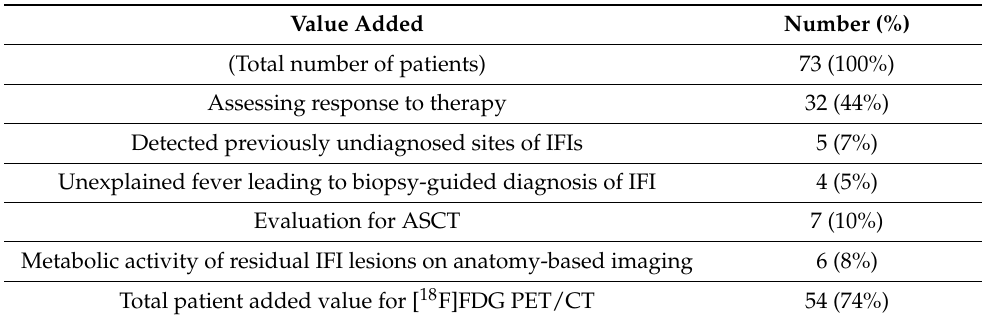
Table 5. Patients for which [ 18 F]FDG PET/CT was considered to add value.